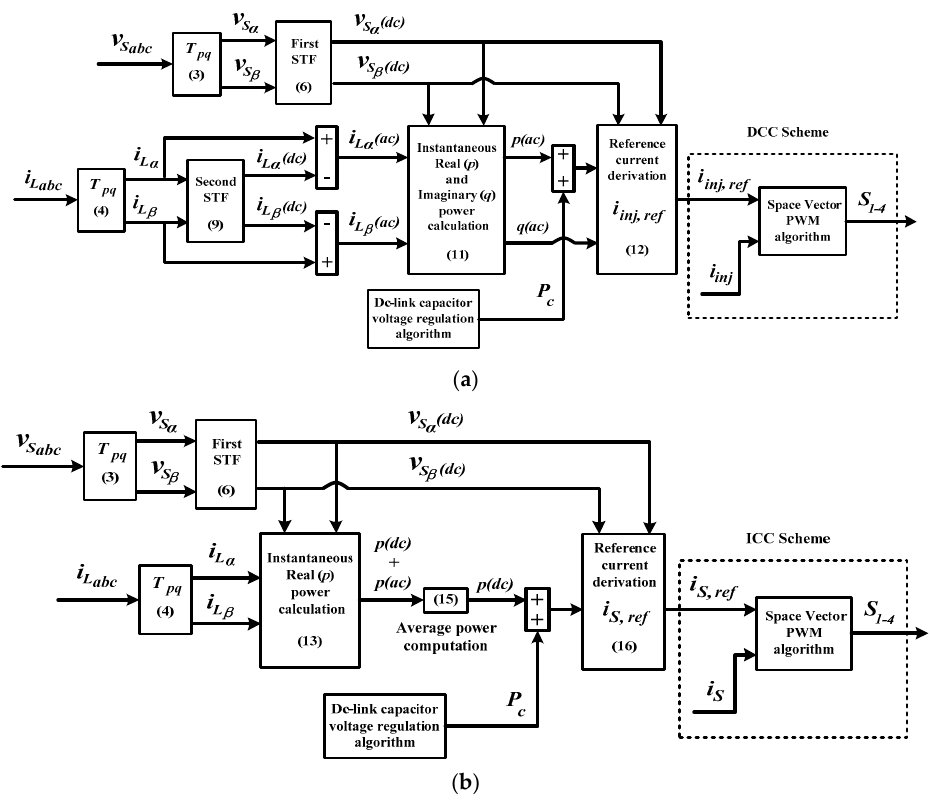
Figure 2. Reference current generation algorithms: ( a ) conventional STF-pq theory and ( b ) refined STF-pq theory.